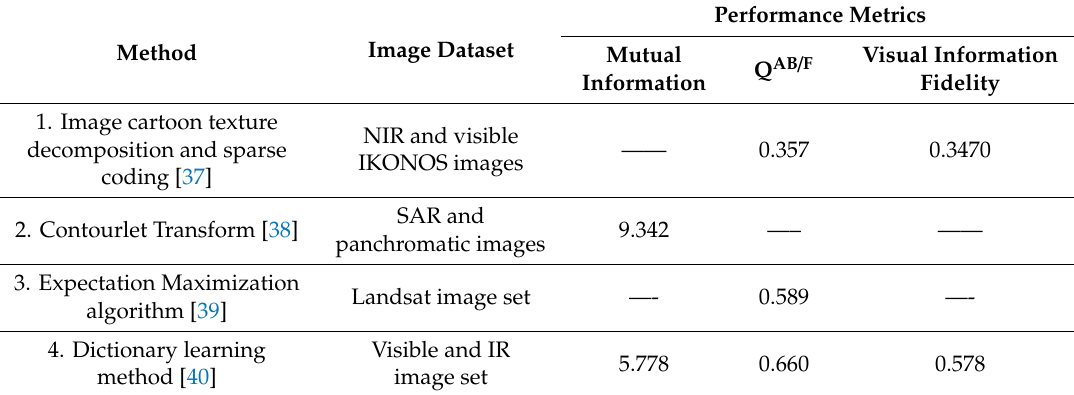
Table 4. Image fusion methods and their performance